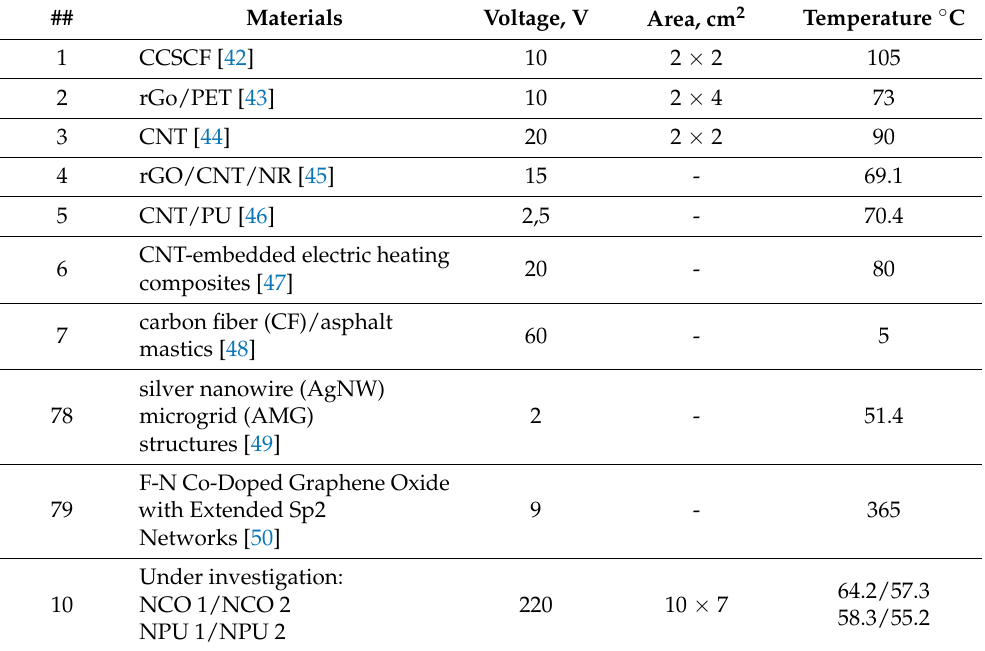
Table 2. Comparing the electrothermal properties of different